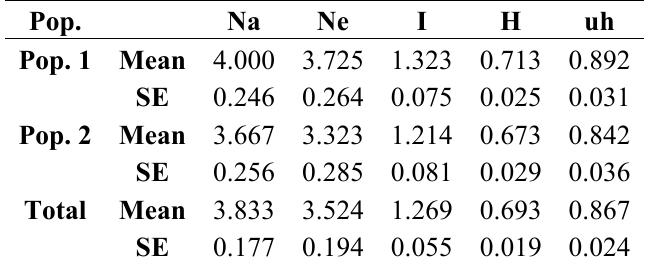
Table 5. Haploid diversity by population. Number of loci = 12, number of samples = 10 (5/5), number of populations = 2. Na = number of different alleles; Ne = number of effective alleles; I = Shannon’s information index; h = diversity; uh = unbiased diversity. Pop. Na Ne I H uh Pop. 1 Mean 4.000 3.725 1.323 0.713 0.892 SE 0.246 0.264 0.075 0.025 Pop. 2 Mean 3.667